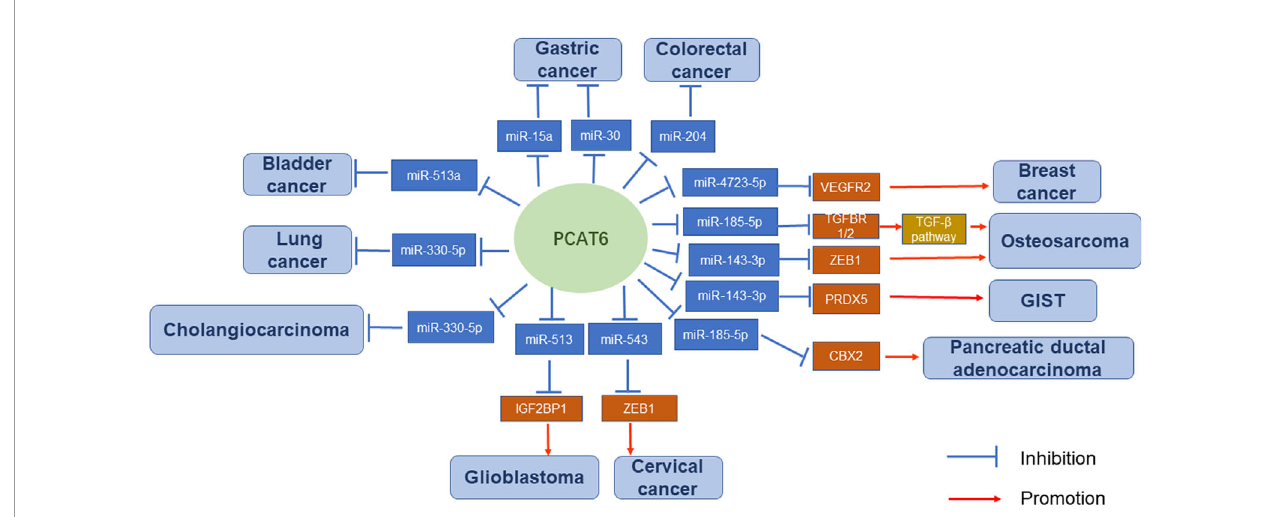
FIGURE 2 | Overview of lncRNA PCAT6 binding to